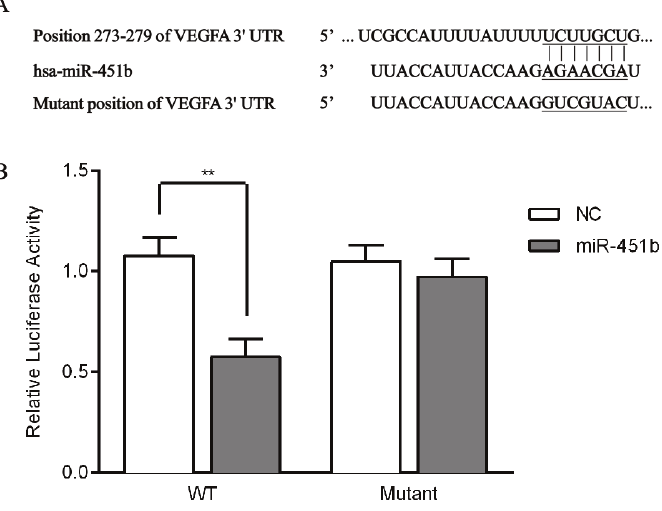
Figure 2: VEGFA is a direct target of miR-451b. (A) The binding sites between miR-451b and the 3’-UTR of VEGFA. (B) Dual-luciferase reporter assay was performed to verify the binding sites between miR-451b and the 3’-UTR of VEGFA.